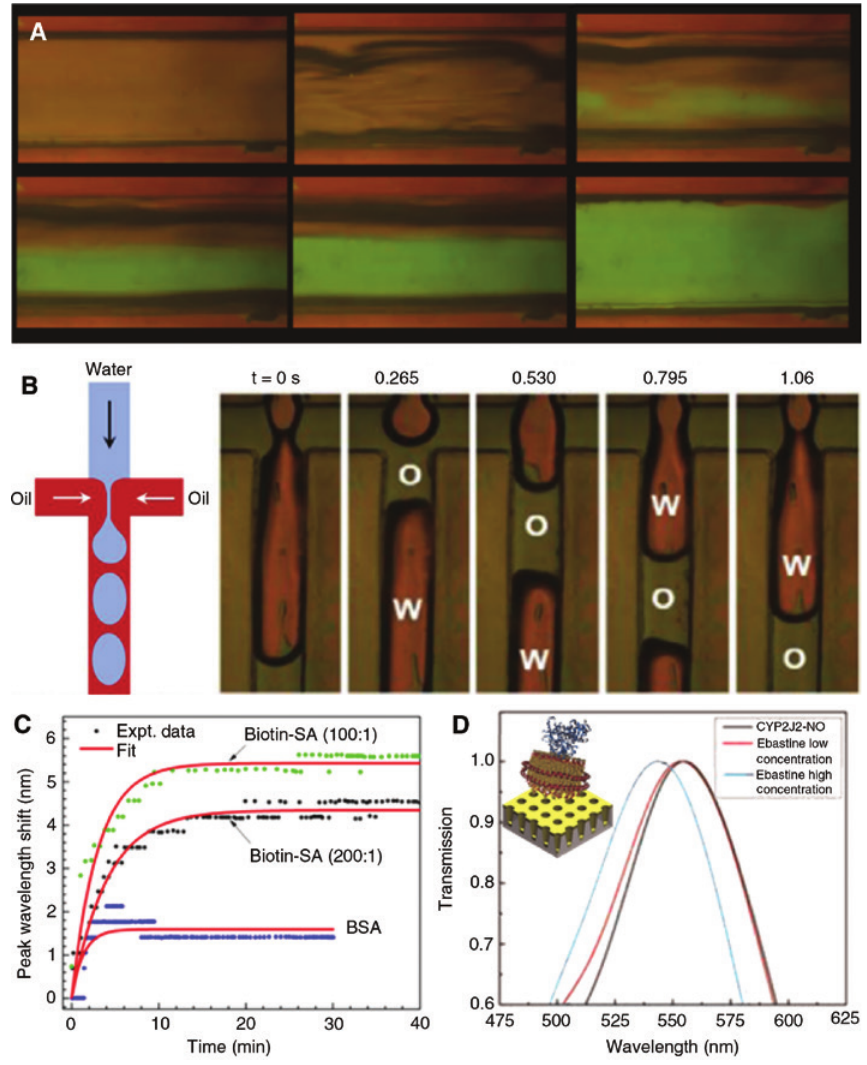
Figure 2: Ultra-sensitive plasmonics for microfluidic sensing. (A) A series of video snapshots to demonstrate the real-time sensing functionality of FlexBrite in microfluidics. In a microfluidic channel (width = 500 μ m) with FlexBrite in the bottom, glycerol is replaced with water (adapted from Ref. [34] with permission from The Royal Society of Chemistry). (B) Schematic of the microfluidic droplet generation nozzle region with top inlet for water and side inlets for oil (solid arrow indicates the direction of the flow); time-lapse reflection images of water (W) droplet formation, release, and re-formation in oil (O) emulsion at the nozzle region. (C) Streptavidin (SA)-biotin representative association curve on nanoLCA sensor immobilized with biotinylated thiol where two concentrations (100:1 and 200:1 dilution ratio) of streptavidin solution were used. BSA association curve on Au nanohole array sensor via adsorption (B and C reproduced from Ref. [37] under Creative Commons License). (D) Spectral blue shift from a high and low concentration of ebastine binding with immobilized CYP2J2-ND. Inset: Schematic of the CYP2J2-ND system with CYP2J2 protein (blue) incorporated into the nanodisk. The nanodisk consists of a phospholipid bilayer (gold) and two membrane scaffold proteins (red) (C and D adapted from Ref. [38] with permission from